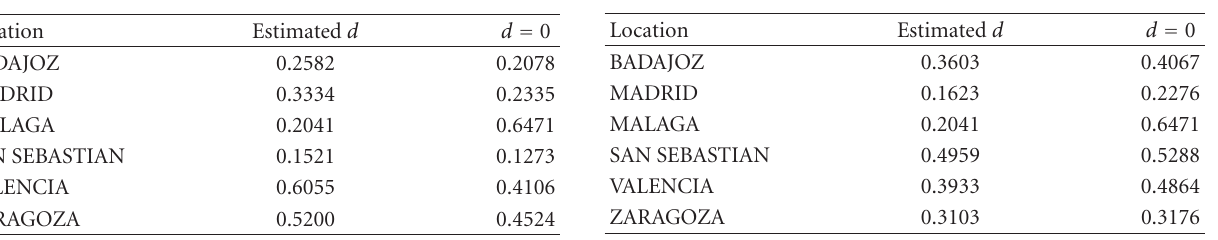
Table 8: Annual increase in the temperatures (in 0.1 ◦ C) using the same sample size. Series: T min